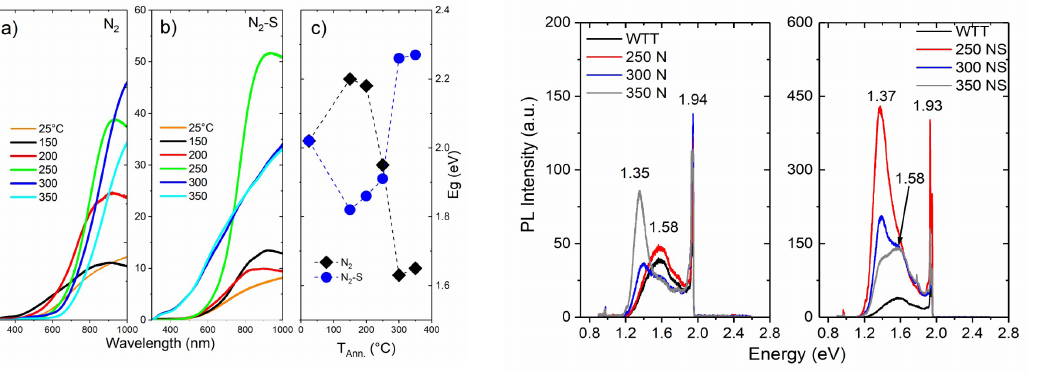
Figure 6. Photoluminescence spectra of the film annealed at different a) In a nitrogen atmosphere, b) in a nitrogen-sulfur atmosphere,